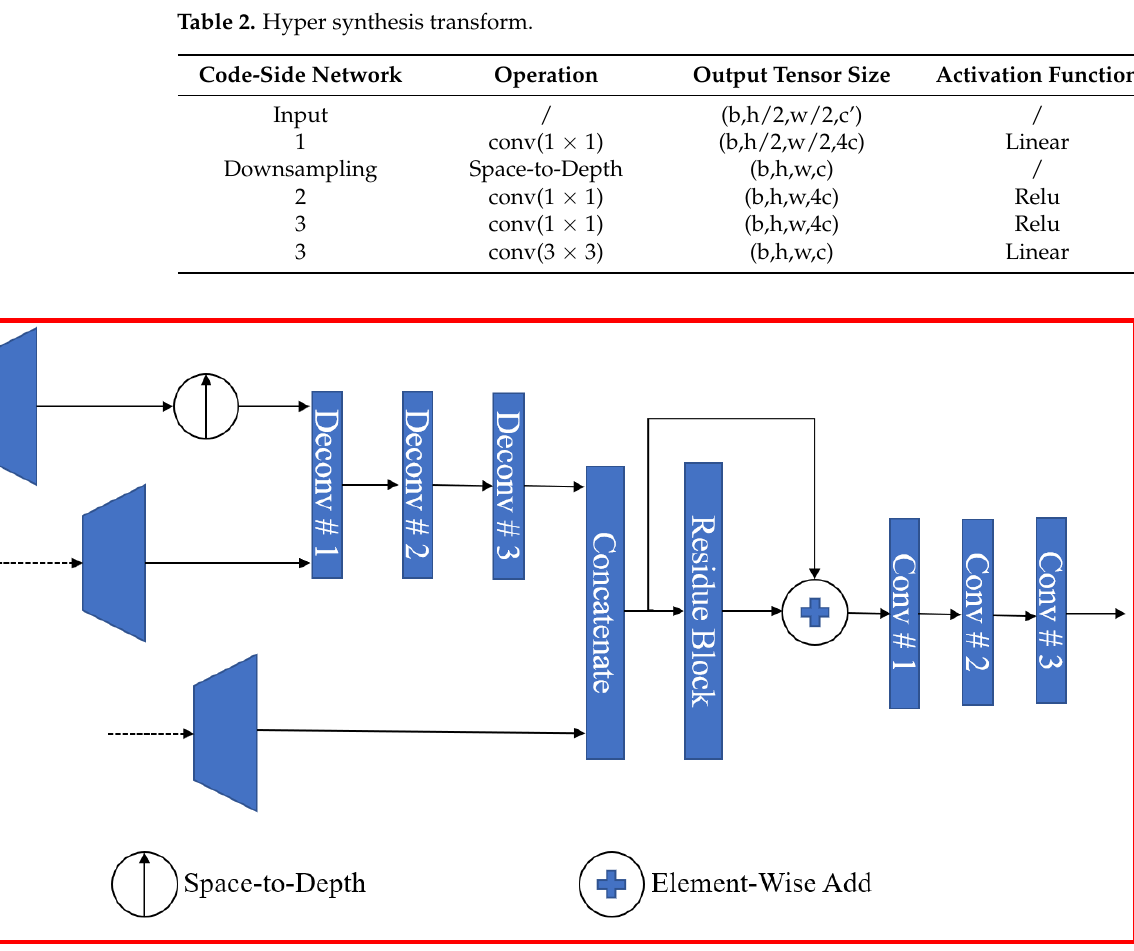
Figure 2. Information Aggregation Decoding